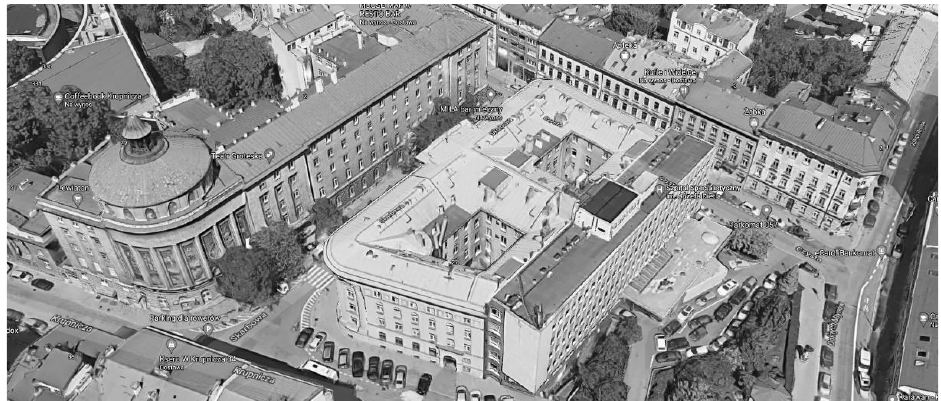
Figure 8. Atrial layout. ( a ) Planimetric scheme; ( b ) Axonometric scheme; ( c ) Axonometric scheme with the minimum area that must be dedicated to the infectious disease section indicated red.